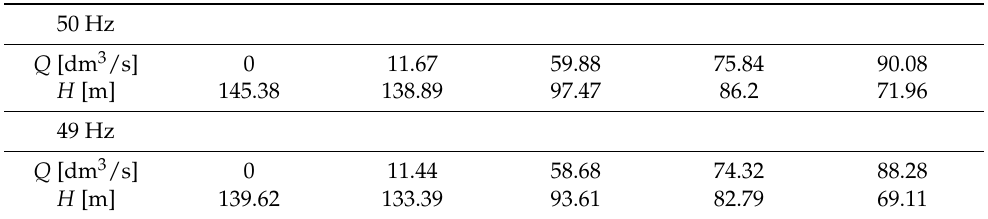
Figure 5. Testing of SP 270-3A G pump in the laboratory. Table 1. Values for the curve that relates total head and flow of the SP 270-3A G pump measured in the laboratory at 50 Hz and recalculated for 49 Hz.